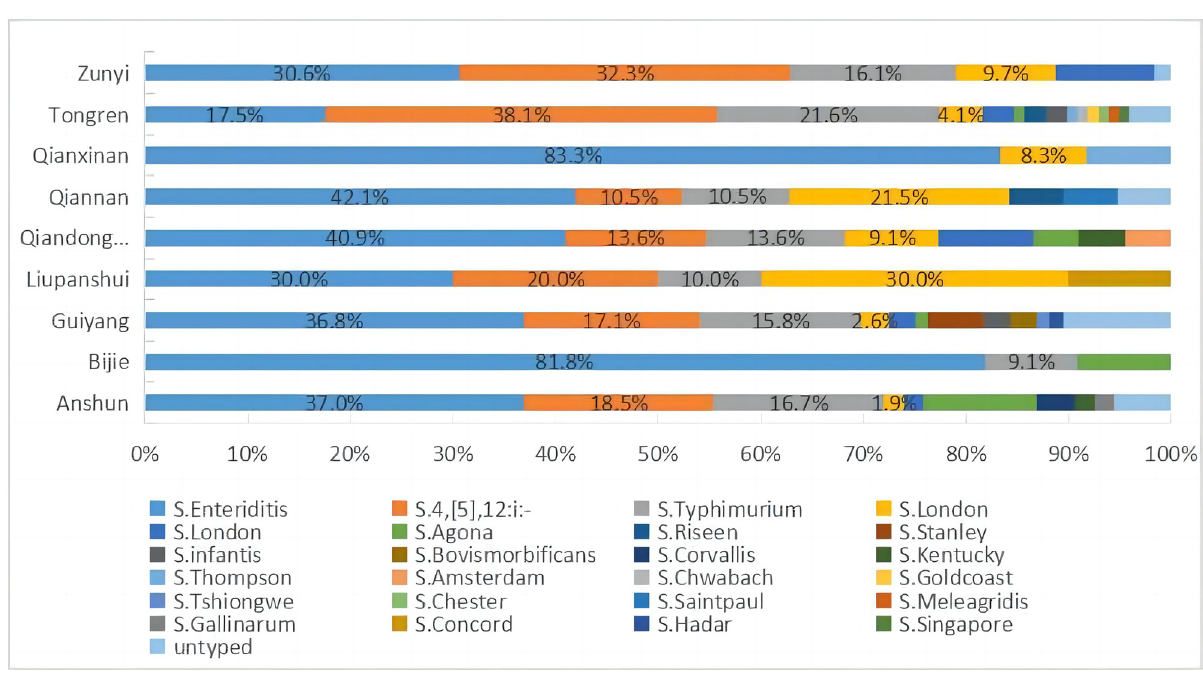
Fig 1. The serotype distribution of Salmonella isolates from six cities and three autonomous prefectures in Guizhou province between 2013 and 2018.